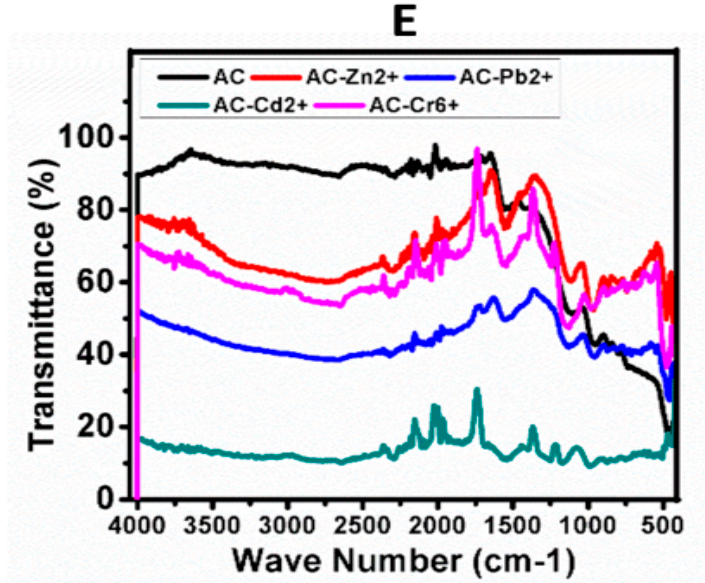
Figure 2. The nitrogen adsorption-desorption isotherms ( A ), Raman spectra ( B ), XRD spectra ( C ) and FESEM surface morphology of the activated carbon ( D ). The infrared spectra of the activated carbon before and after treatment with the aqueous solution of heavy metal ions is shown in ( E ).